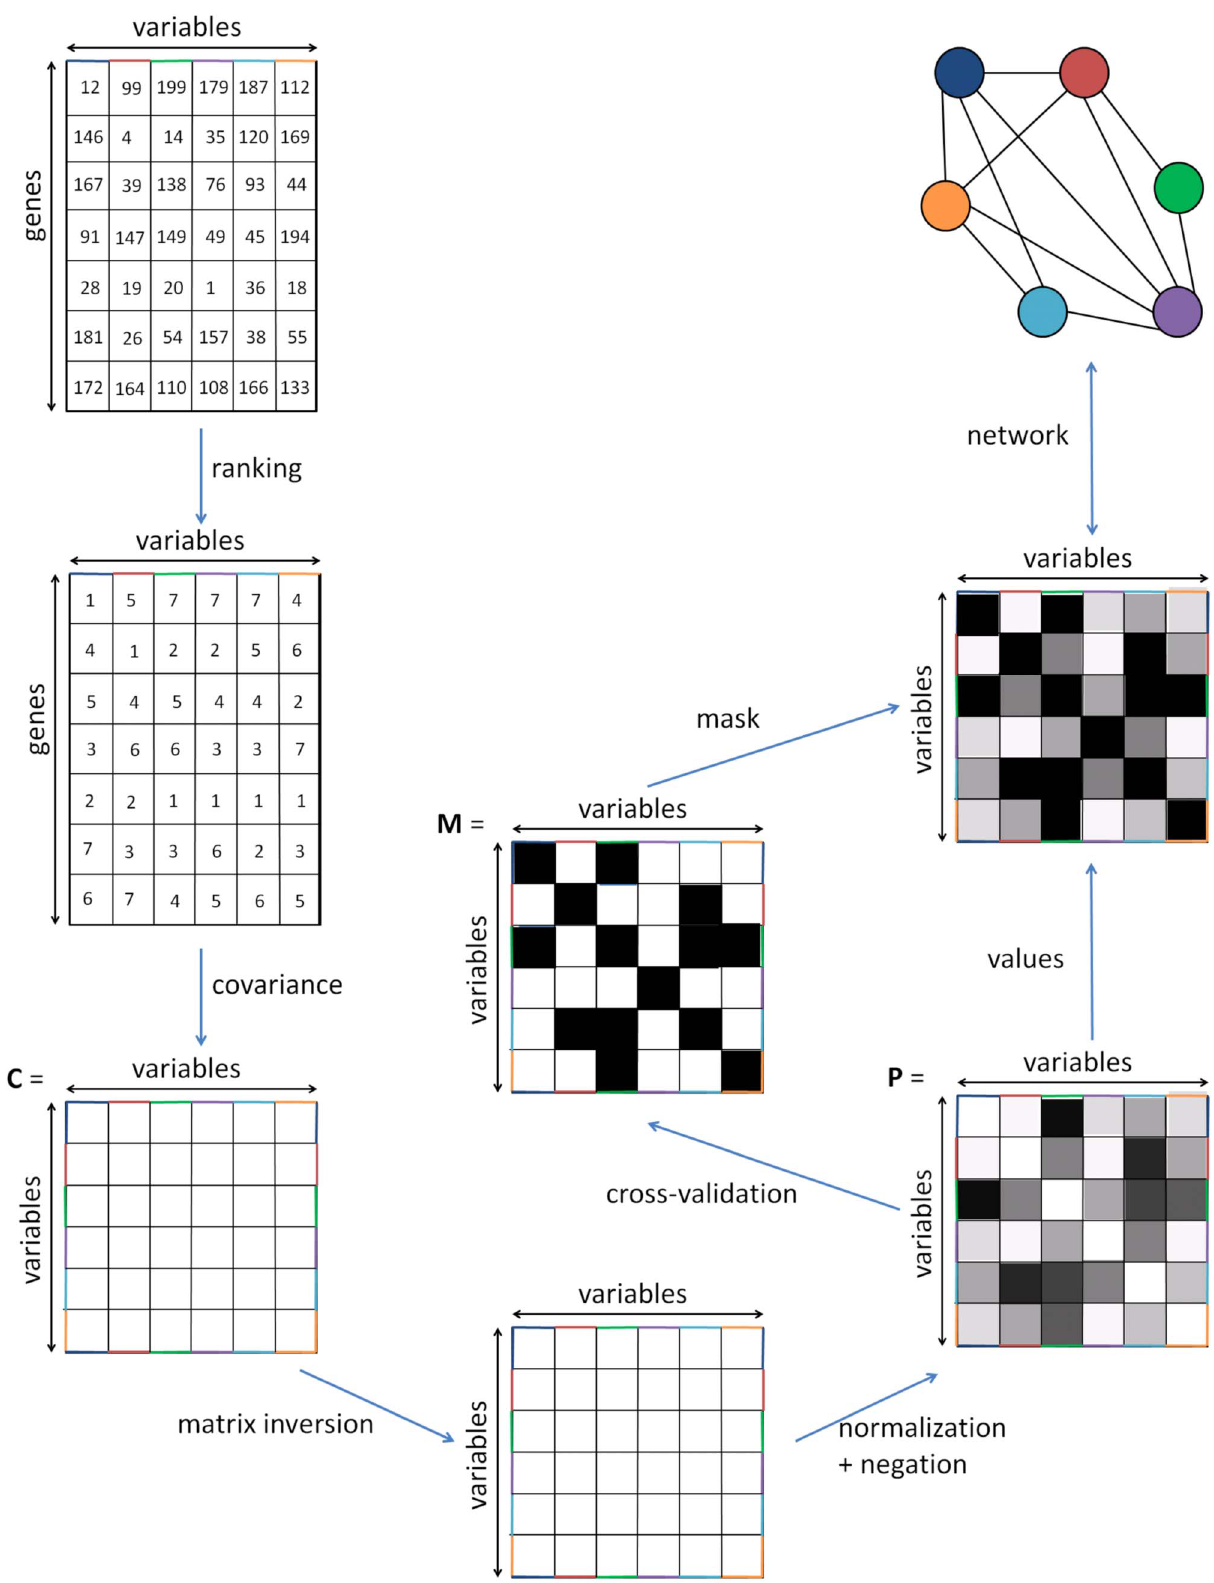
Figure 1. Global view of the algorithm. The data matrix is rank-transformed, and the covariance matrix C is computed. C is then inverted, negated and normalized as described in Materials and Methods to obtain the partial correlation matrix P . Cross-validation is performed to build a mask M which is applied on P to give a sparse partial correlation network. doi:10.1371/journal.pcbi.1003168.g001 PLOS Computational Biology |